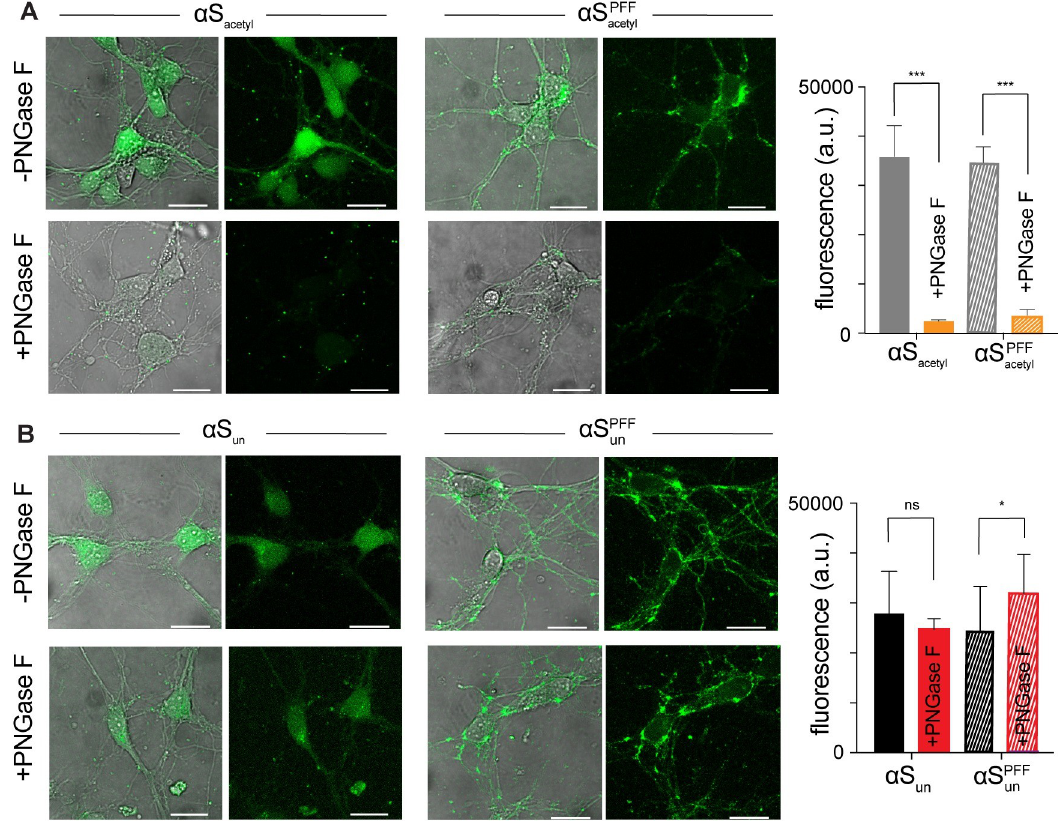
Fig 3. Complex N-linked glycans selectively enhance uptake of α S acetyl by primary hippocampal neurons. (A) Representative images of mouse hippocampal neurons cells following 12-hour incubation with monomer or PFF α S acetyl -AL488, − /+ PNGase F treatment. Uptake quantified by total cellular fluorescence. (B) As in (A) but for monomer and PFF α S un -AL488. All internalization measurements with 200 nM monomer or 200 nM PFF (monomer units, 20:1 α S: α S-AL488); n = 100 cells, 3 independent experiments, � P < 0.01 and ��� P < 0.0001 by Student t test). Scale bars = 20 μ m. The underlying data for this figure can be found in S1 Data. α S, α -Synuclein; α S acetyl , N-terminally acetylated α S; α S un , unmodified α S; AL488, Alexa Fluor 488; PFF, preformed fibril; PNGase F, peptide-N-glycosidase